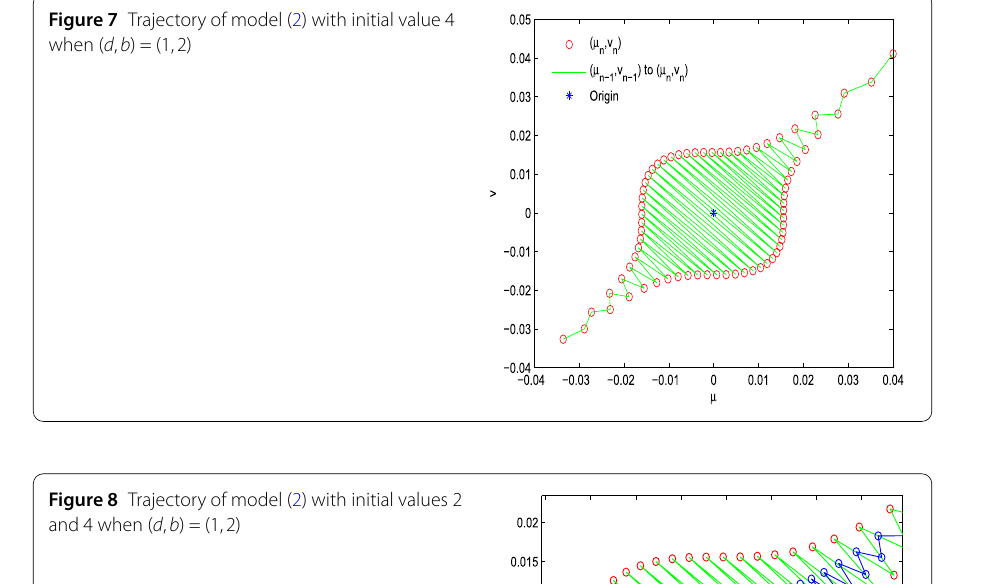
Figure 8 Trajectory of model (2) with initial values 2 and 4 when ( d , b ) = (1,2)